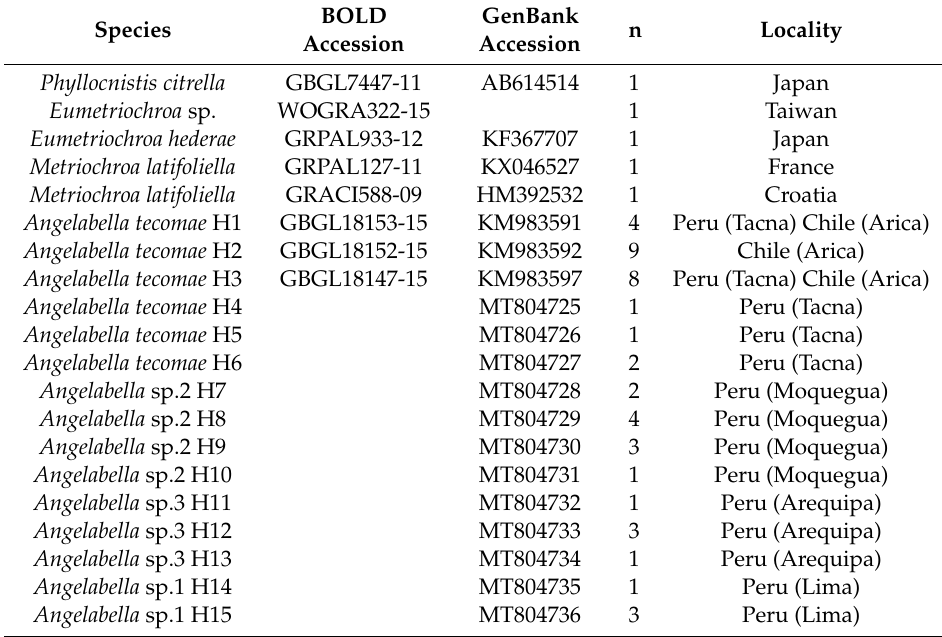
Table 1. Sequences Used in the Analyses of this Study. Haplotypes H4 to H15 Are New. BOLD GenBank Species Accession